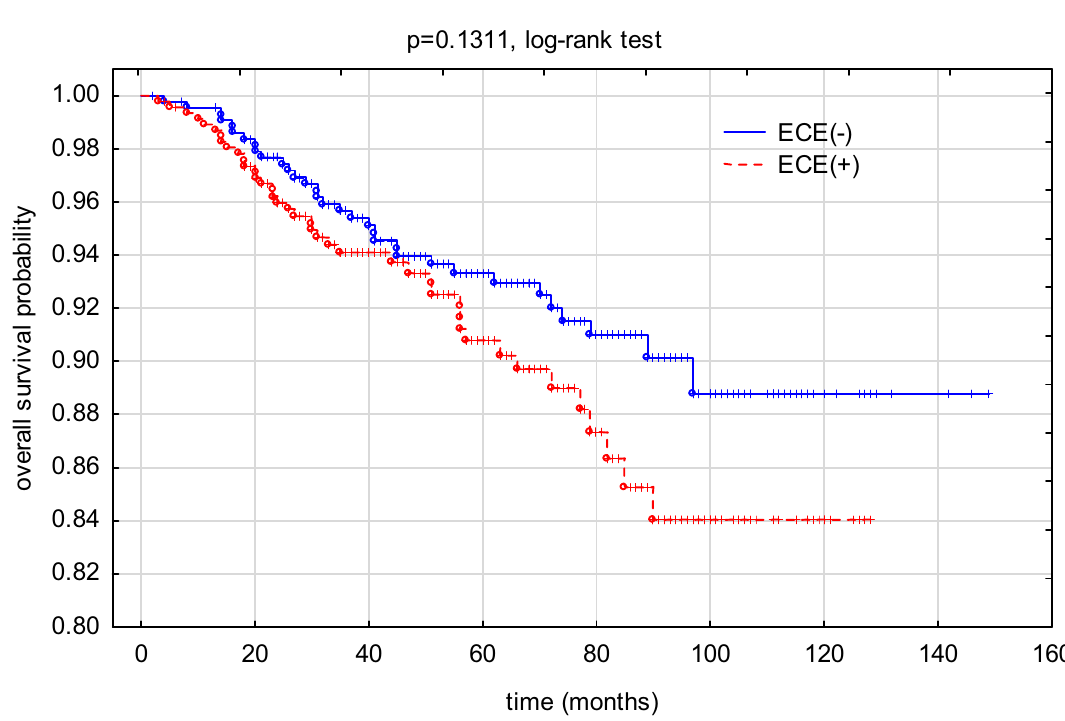
Figure 2. An overall survival probability (pOS) rate in the analyzed group depending on the presence of